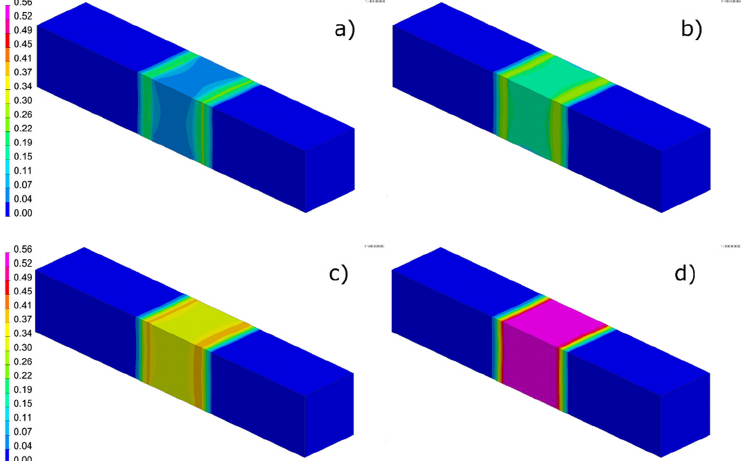
Figure 16. The calculated bainite distributions for: ( a ) TC0—maximum 77.7%, ( b ) TC1—maximum 84.9%, ( c ) TC3—maximum 68%, ( d ) TC6—maximum 46.6%.